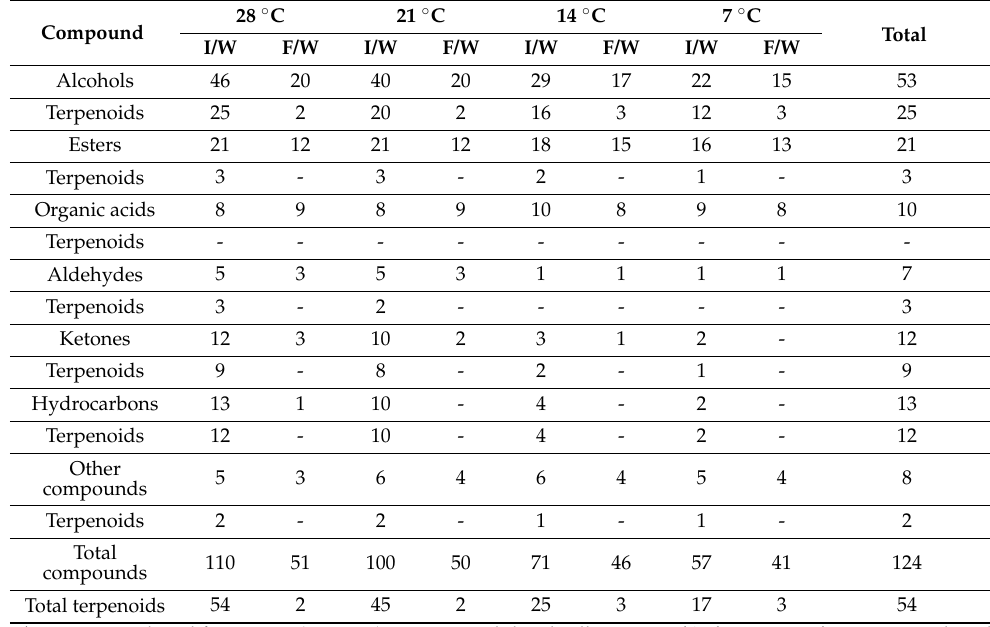
Table 6. Number of volatile by-products detected by SPME/GC-MS analysis in must